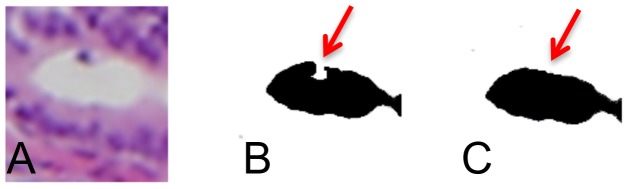
Crescent Issue.
A An example cribra compared with an illustrative B cribra segmentation. Here is an example of the crescent issue (red arrow) that can occur before a closing operation, where the cribra is not a smooth surface but has a crescent-like gap. C This shows an illustration of how the closing operation can fix this type of issue.